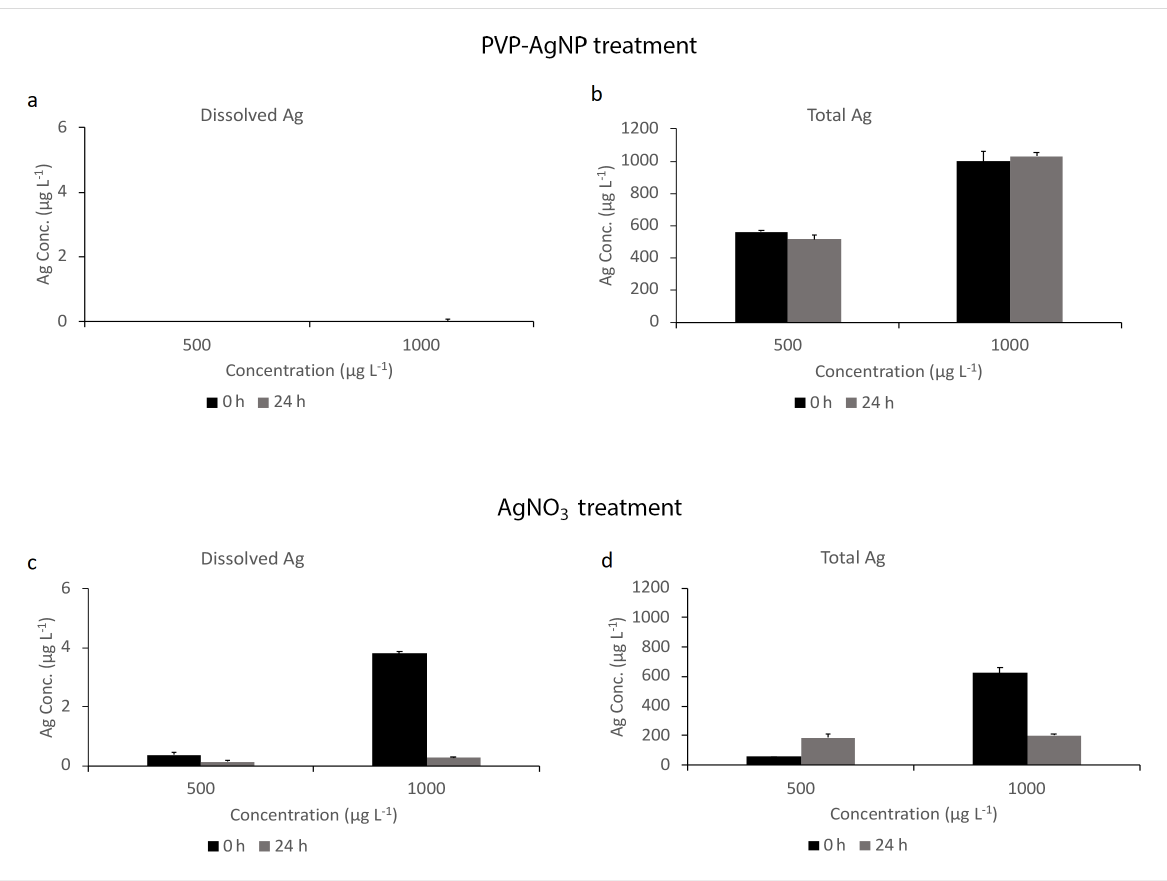
Figure 3: Dissolved and total Ag concentration in PVP-AgNPs and AgNO 3 . Dissolved Ag concentration measurements using centrifugal ultrafiltration units (a and c), and total Ag concentration (b and d) in RPMI medium at t = 0 and t = 24 h measured by ICP-MS. All experiments were performed in triplicates and are reported as mean ± SE ( n = 3).